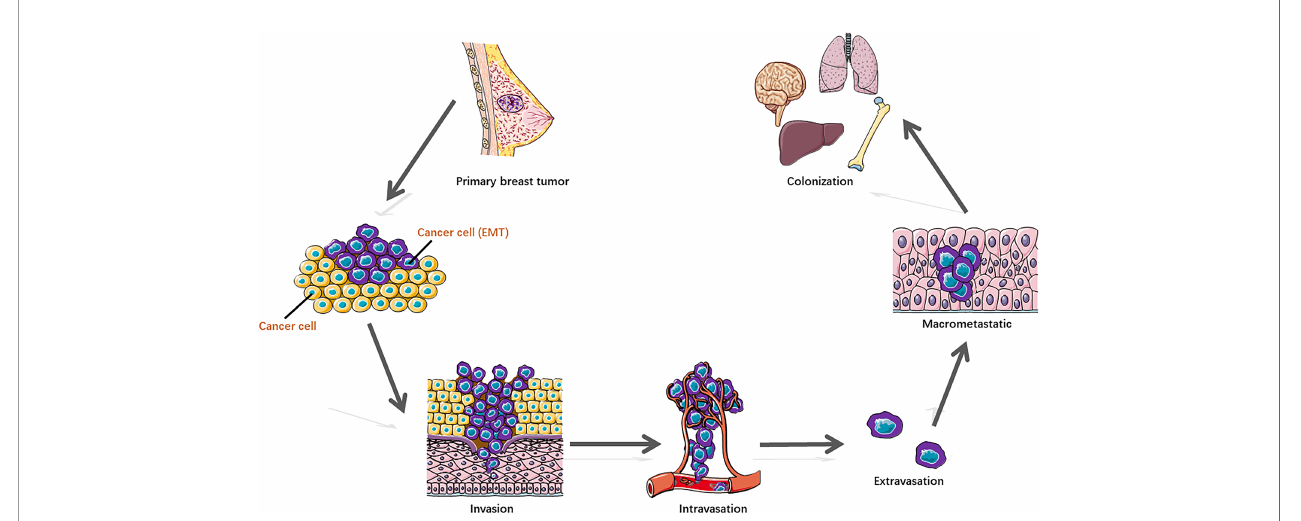
FIGURE 1 | Distant metastasis colonization consists of sequential